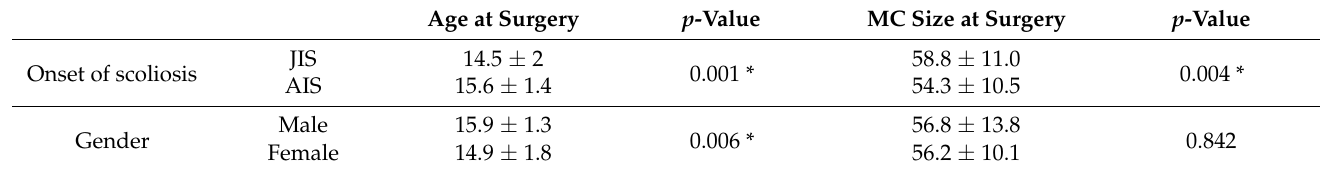
Table 3. Correlation of scoliosis onset and sex with age and MC at